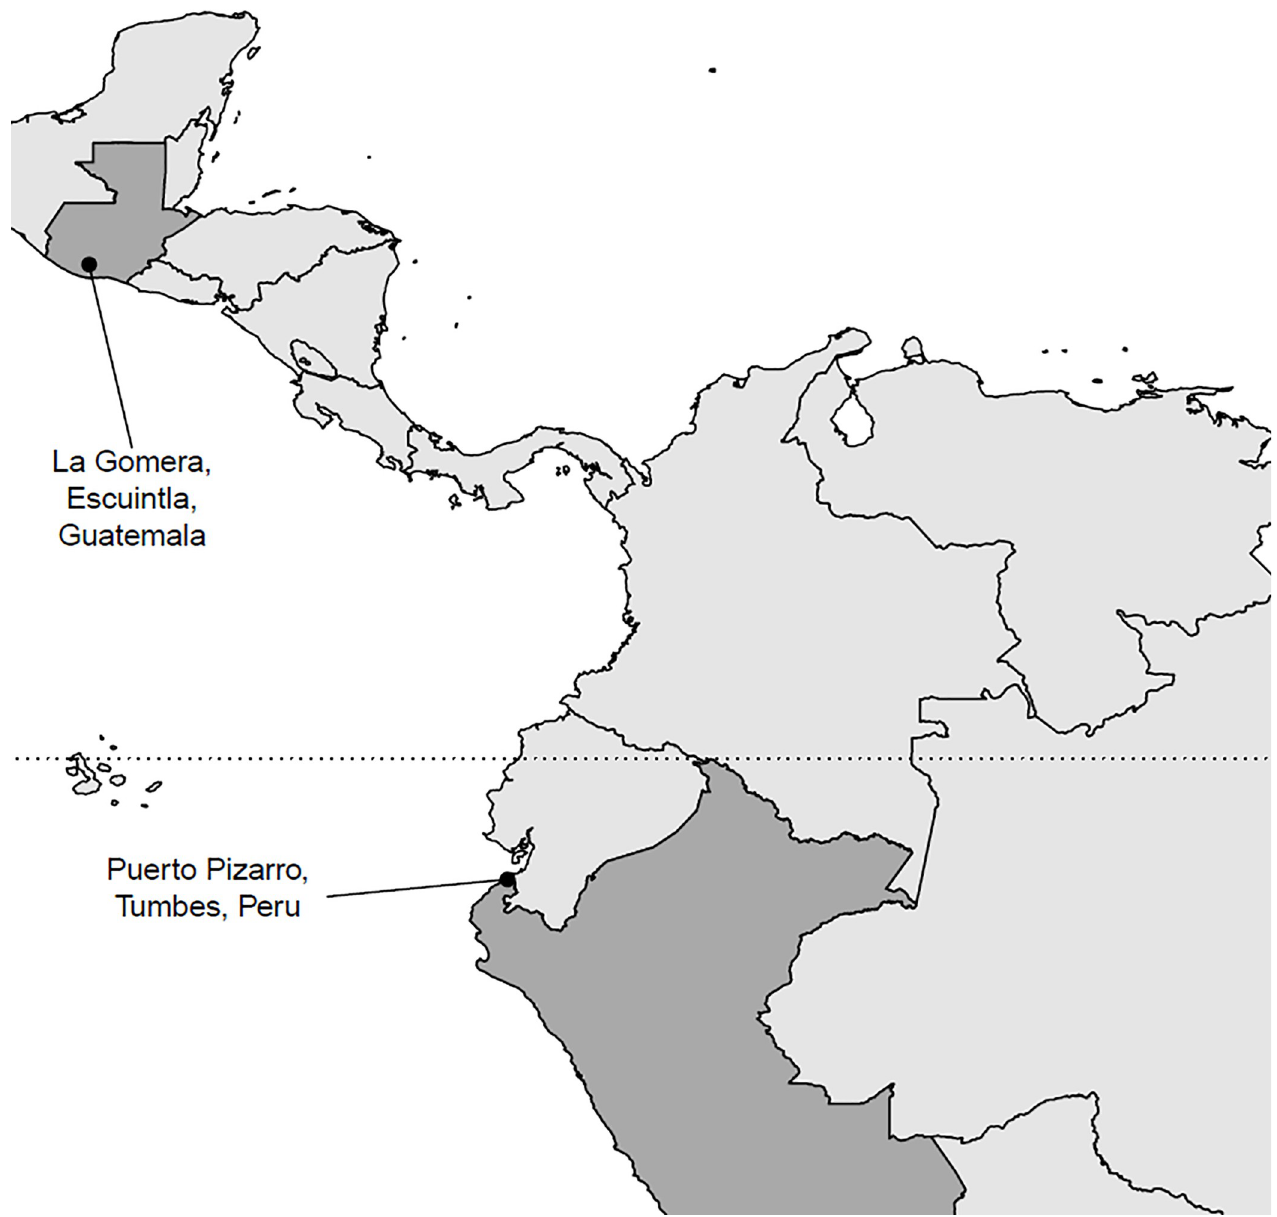
Fig 1. Locations from which mosquitoes were sampled in this study. Guatemala and Peru are shaded in dark grey and sample locations are labelled. The dotted line indicates the equator. https://doi.org/10.1371/journal.pone.0210586.g001 with pools of 5 mosquitoes each were prepared according to the following: the susceptible labora- tory colony Sanarate (San); field-collected mosquitoes from Guatemala not exposed to insecticide (GTM-unx) and alive after exposure to deltamethrin (GTM-delta); field-collected mosquitoes from Peru not exposed to insecticide (PER-unx), alive after exposure to deltamethrin (PER-delta) and alive after exposure to alpha-cypermethrin (PER-acyp). The number of mosquitoes from La Gomera, Guatemala alive after exposure to alpha-cypermethrin was insufficient for RNA extrac- tion hence RNA-Seq analysis was not done for this group. RNA was extracted using the Applied